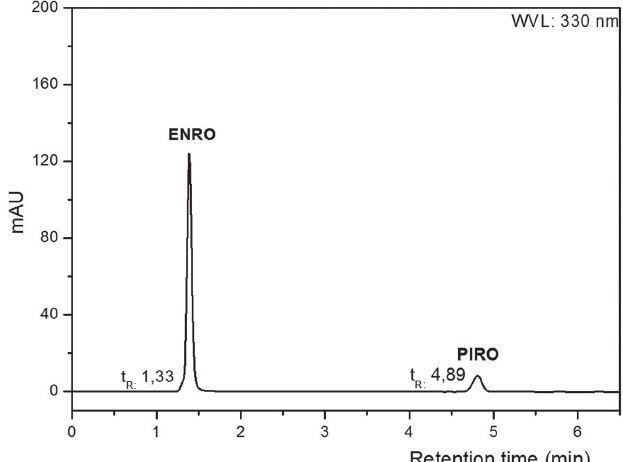
FIGURE 2 - Chromatogram of enrofloxacin and piroxicam in a pharmaceutical formulation. t , retention time. Conditions : R mobile phase composed of acetonitrile:water (48:52, v/v); pH 3.0; column Vertisep C18; flow rate 1.0 mL min –1 ; injection volume 20